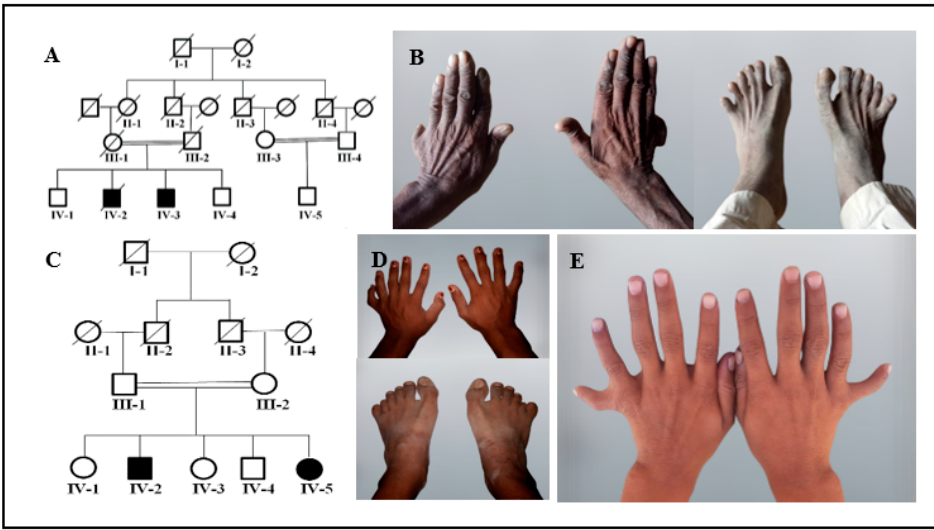
Figure 1. Pedigrees and images of family A and family B. ( A ) Pedigree of family A showing autosomal recessive inheritance. Blank “Square” and “circle” presents normal males and females while shaded “square” and “circle” presents affected males and females, respectively. A diagonal line over the “square” and “circle” indicates deceased individuals. Double lines between “square” and “circle” shows the consanguineous marriage. ( B ) Images of affected member IV-2 of family A displaying PAPA in both hands and feet, 2/3 cutaneous syndactyly in both feet and clinodactyly in both hands. ( C ) Pedigree of family B presenting autosomal recessive inheritance. Blank “Square” and “circle” presents normal males and females while shaded “square” and “circle” presents affected males and females, respectively. A diagonal line over the “square” and “circle” indicates deceased individuals. Double lines between “square” and “circle” shows the consanguineous marriage. ( D ) Images of the hands and feet of individual IV-2 of family B showing PAPA in the left hand and both feet, sixth finger clinodactyly in the right hand, 5/6 cutaneous syndactyly in the right foot, sandal gap, and abnormal big toe shape. ( E ) Image of individual IV-5 from family B demonstrating bilateral PAPA in hands. Table 1. Clinical presentation of the affected members in two unrelated